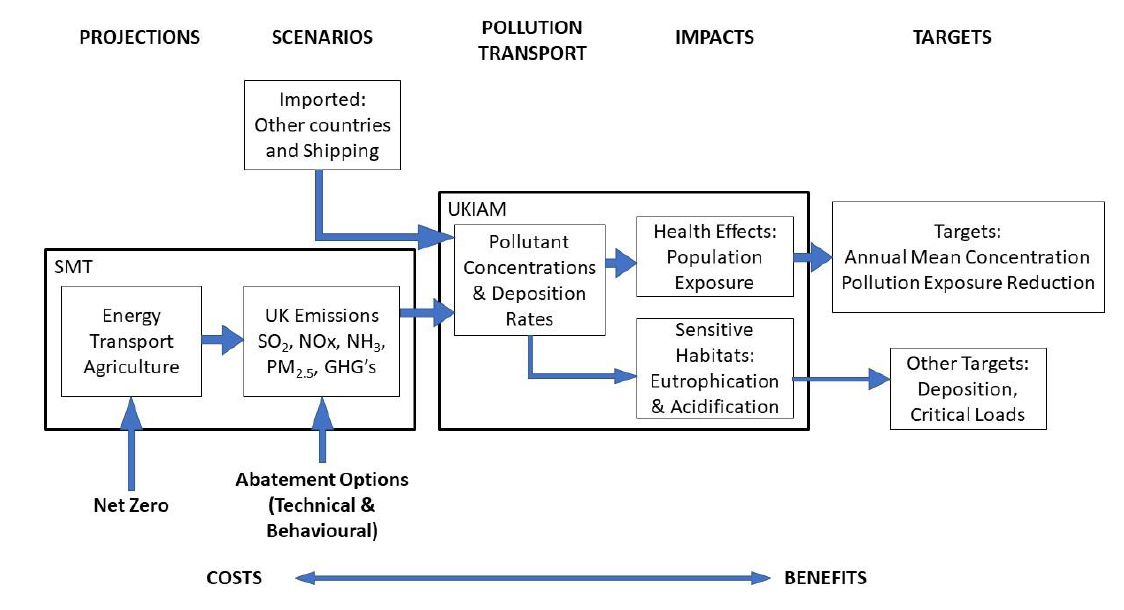
Figure 1. Schematic representation of approach with the scenario modelling tool (SMT) specifying UK emissions scenarios modelled by UKIAM and model outputs used to develop targets for annual mean concentrations and pollution exposure